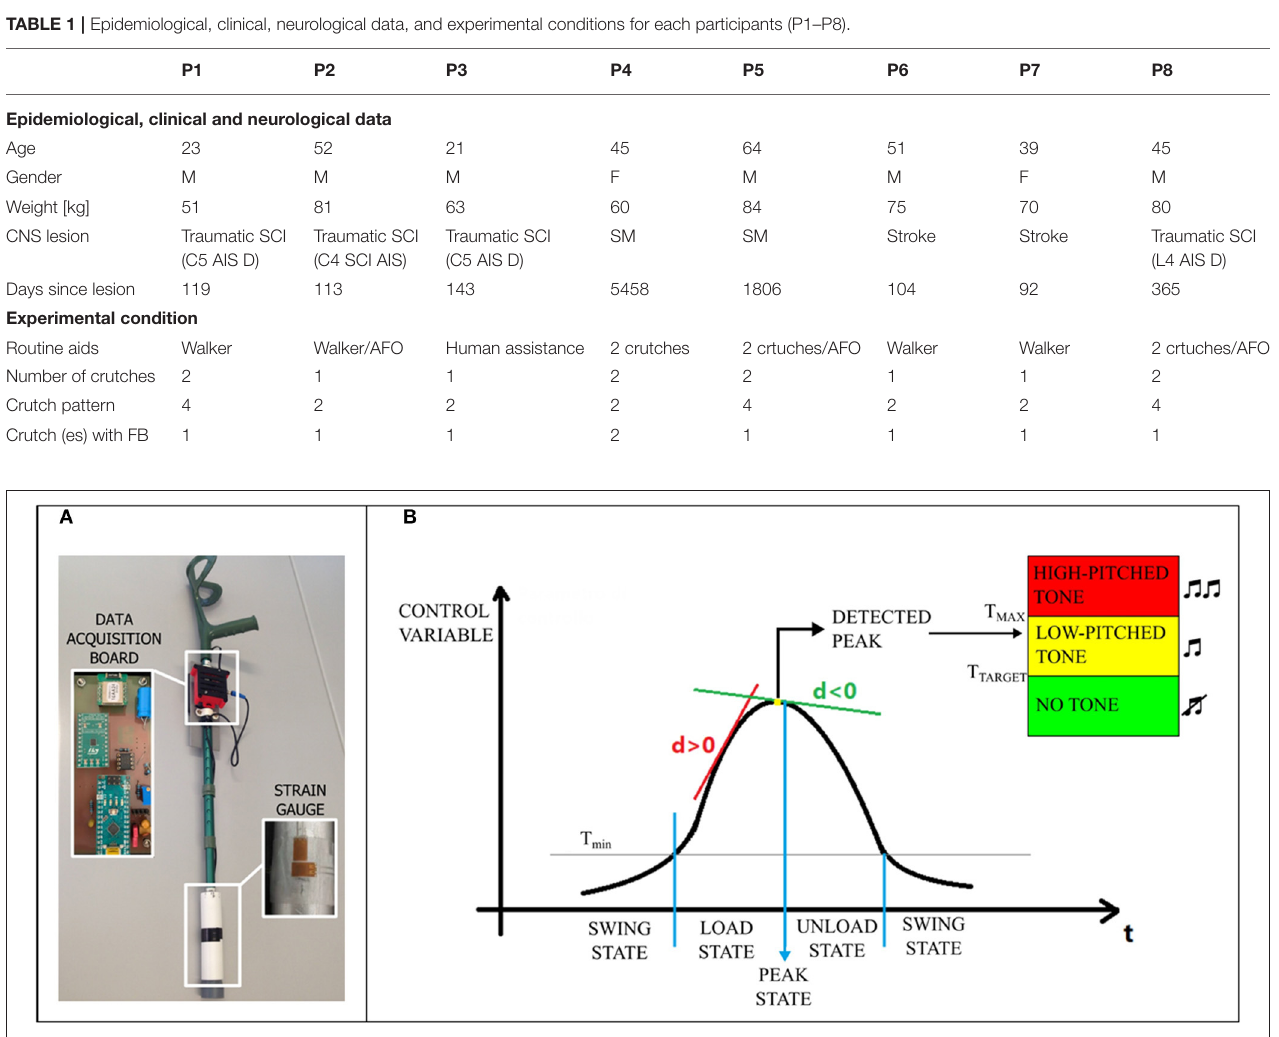
FIGURE 1 | Instrumented crutch (A) and peak detection algorithm description (B)